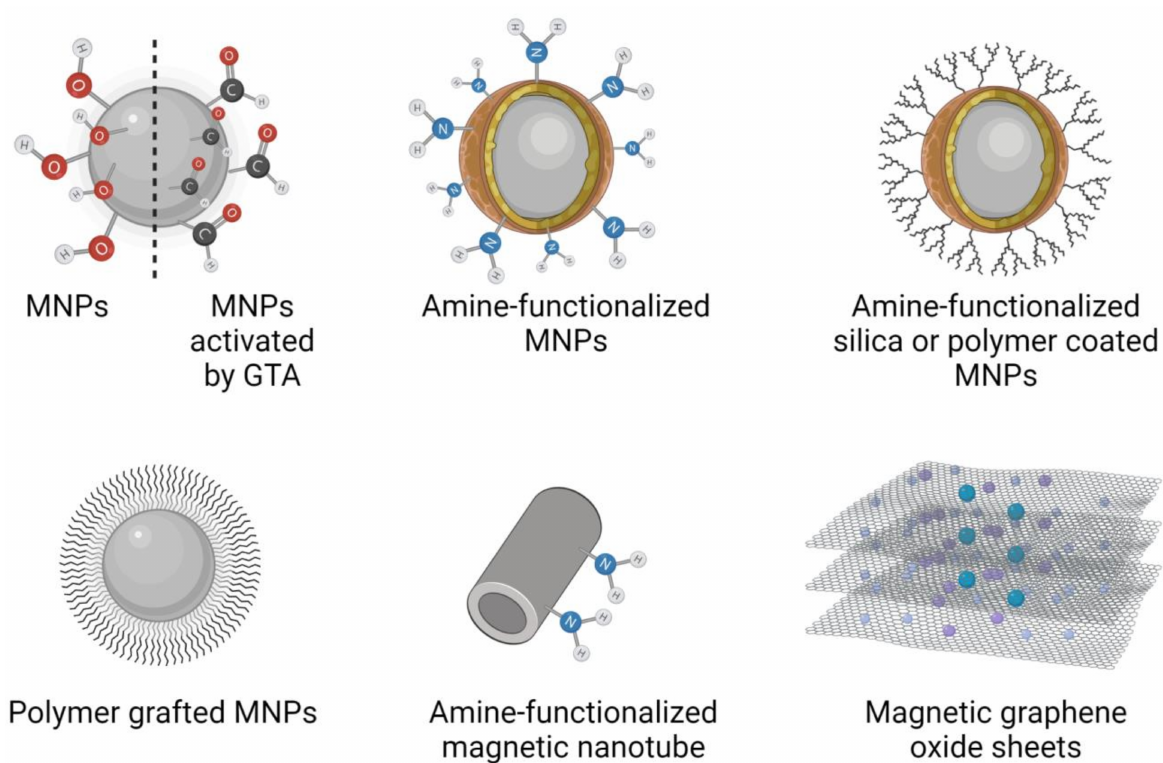
Figure 3. Configurations of amine-terminated MNPs tested as reusable biocatalysts for biomass